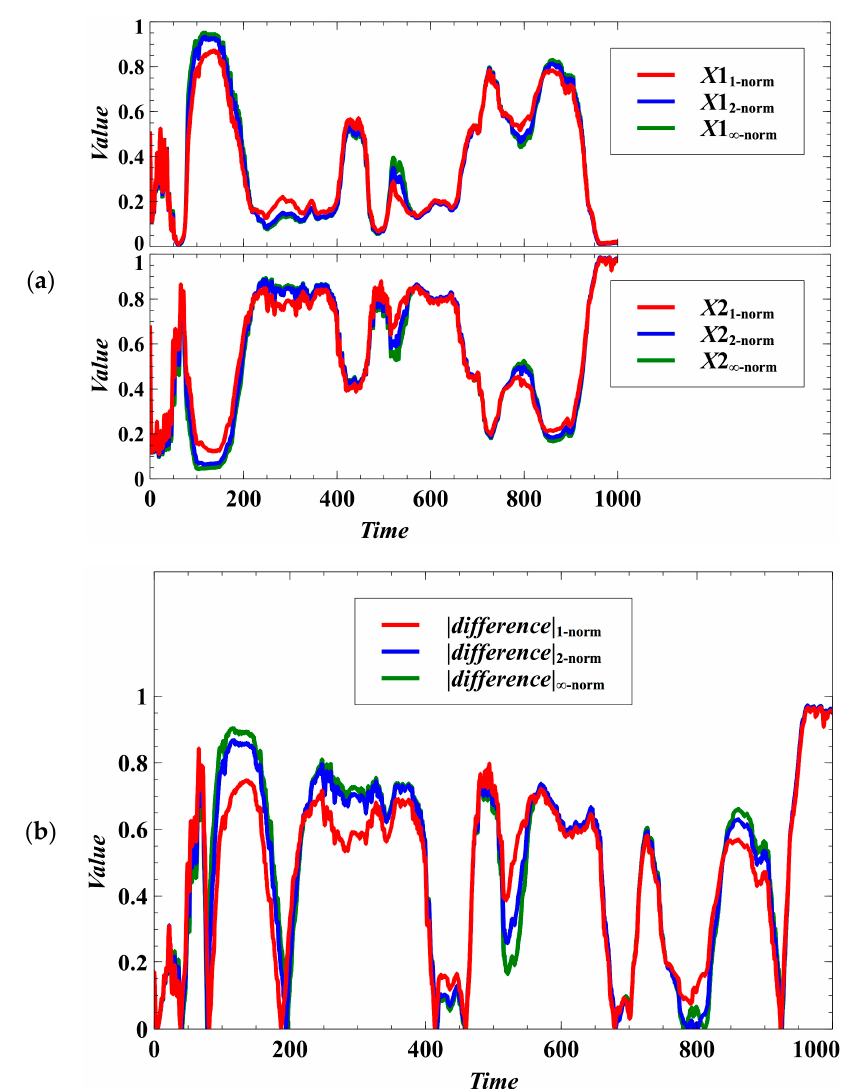
Figure 6. Effect of using different norms in the population dynamics of the host species under the stochastic case. Oscillations arise due to stochasticity, and the temporal patterns of egalitarian sharing of resources becomes indistinguishable. ( a ) Effect on the population densities. ( b ) If the difference is near zero, it means that the competition system is egalitarian.